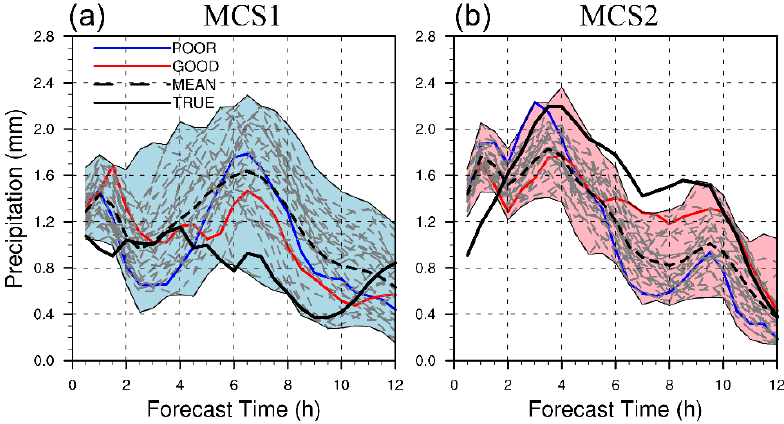
Figure 4. Time evolution of area-averaged 0.5 h precipitation from TRUE (black thick curve), ensemble mean (black dotted curve), ensemble members (gray curves), member 11 (red curve) and member 3 (blue curve) for the ( a ) MCS1 region and ( b ) MCS2 region. The blue and red shadings indicate the upper and bottom limit of ensembles.